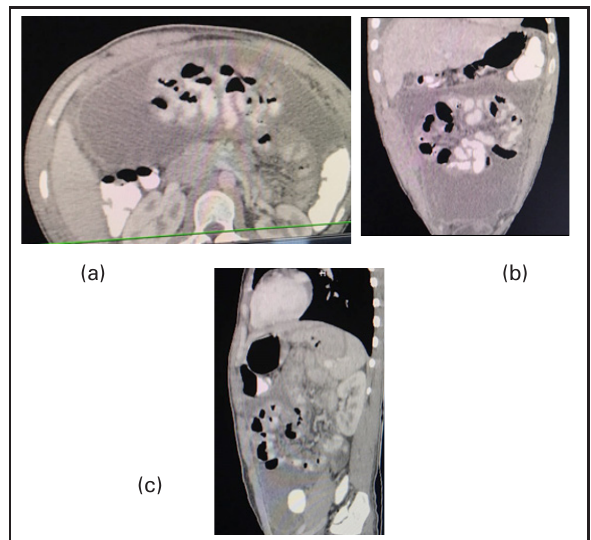
Figure 1. (a) Axial CECT abdomen (soft tissue window) imaging show loculatedascites (solid black arrow) with enhancement and thickening of peritoneum (solid white arrow). (b) Coronal and (c) Sagittal CECT abdomen and pelvis (soft tissue window) imaging show ascites with centrally displaced bowel loops (solid red